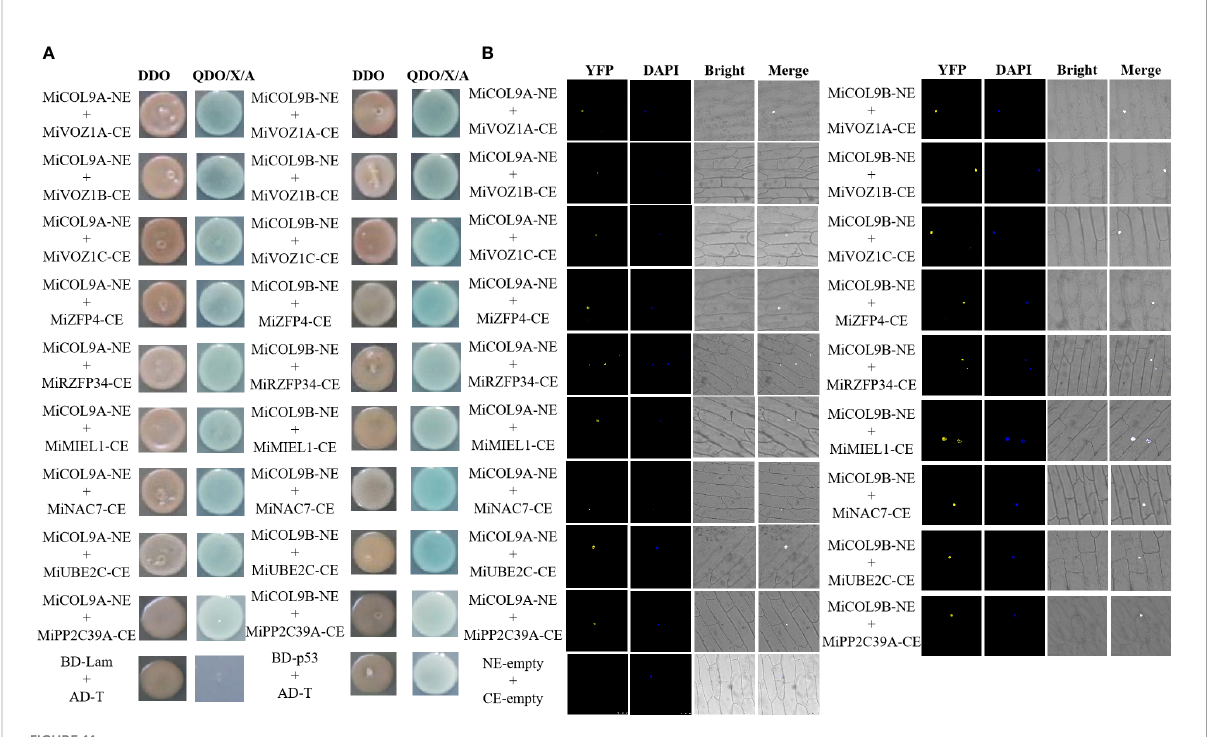
FIGURE 11 Identi fi cation of MiCOL9A and MiCOL9B interacting proteins. (A) Point-to-point veri fi cation. pGBKT7-Lam (BD-Lam) and pGADT7-T (AD-T) were used as negative controls, and pGBKT7-53 (BD-p53) and pGADT7-T (AD-T) served as positive controls. (B) BiFC assays. pSPYCE-empty and pSPYNE-empty were used as negative controls. Bars=100 m